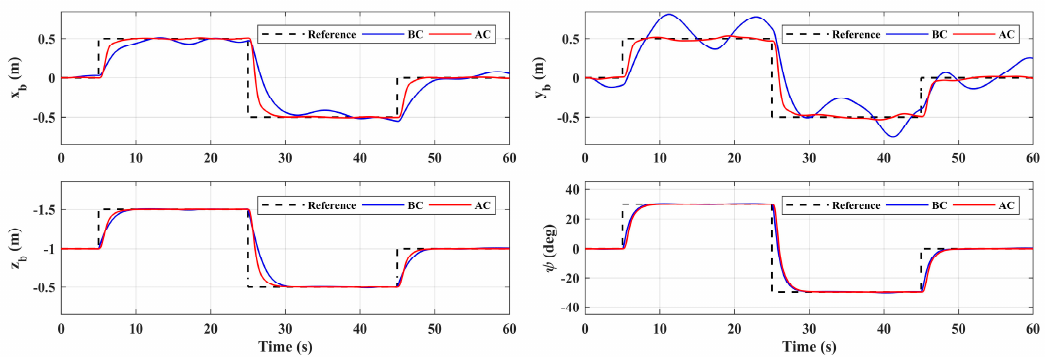
Figure 7. System responses under manipulator motion.